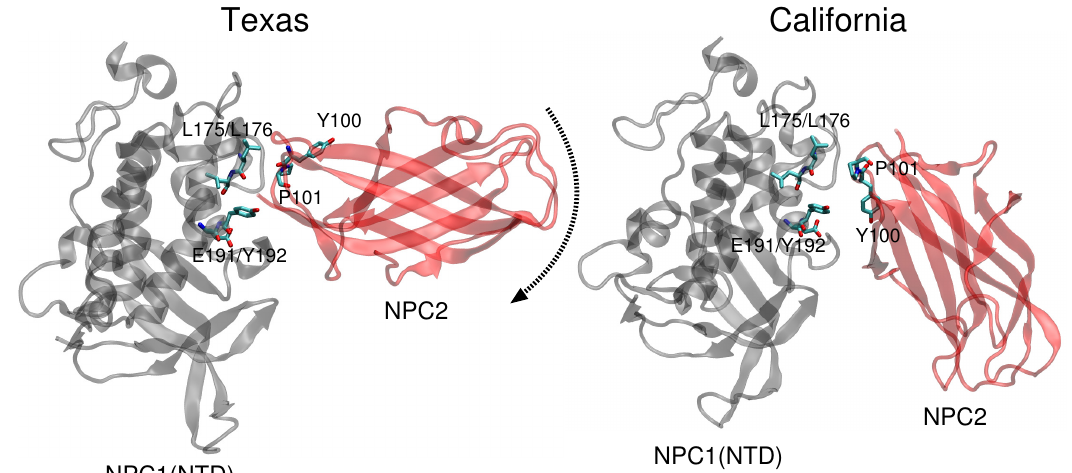
Figure 1. The NPC1(NTD) (gray)–NPC2 (red) complex is shown for the Texas model based on alignment proposed in Ref. [3,6] and for the California model, based on the structure proposed in Ref. [11]. The black dotted arrow indicates the rotation direction that transforms the position of the NPC2 protein in the Texas model to its position in the California model. The California interface results in Y100 of NPC2 being in closer proximity to E191/Y192 of